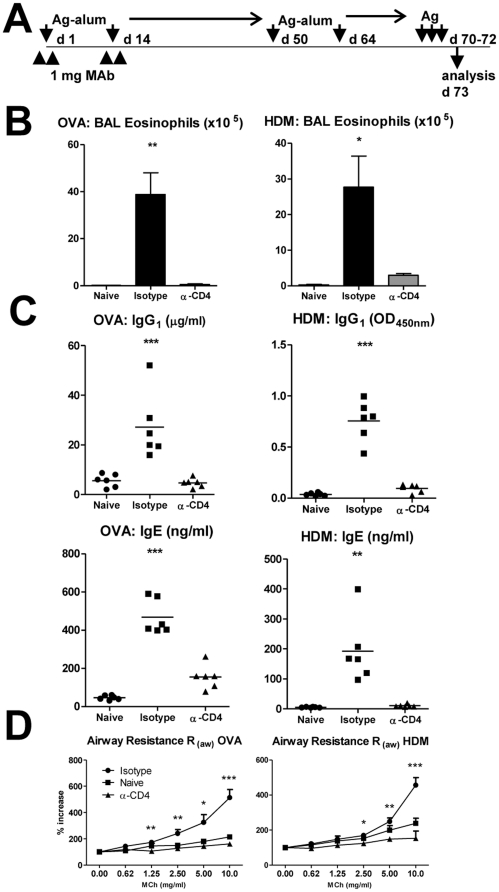
Tolerized mice resist subsequent sensitization and challenge.(A) BALB/c mice were initially sensitized with OVA or HDM under the cover of anti-CD4 as described in Figure 1. Those mice were sensitized with the same antigens on days 50 and 64, and subsequently challenged i.n. (B) Animals trated with anti-CD4 were protected from BAL eosinophilia (n = 6, ** P<0.01 for OVA; * P<0.05 for HDM). (C) CD4-blockade prevented production of IgG1 and IgE in subsequent sensitizations (n = 6, *** P<0.001 and ** P<0.01 as indicated). (D) Tolerance to OVA or HDM prevented AHR to inhaled MCh (n = 6). Data are representative of three independent experiments.